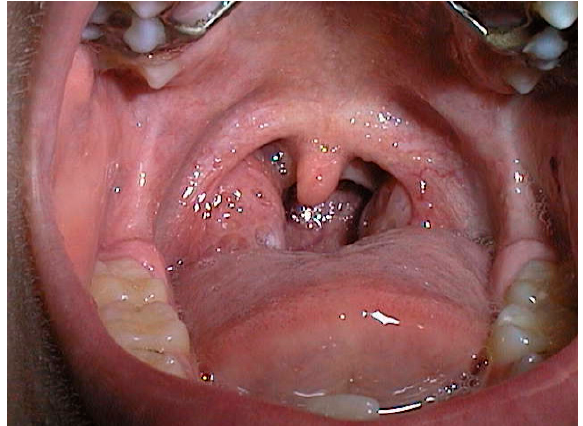
Figure 1. Grade III tonsil hypertrophy in a 6 year-old child. Courtesy of Professor C. Vicini—Department